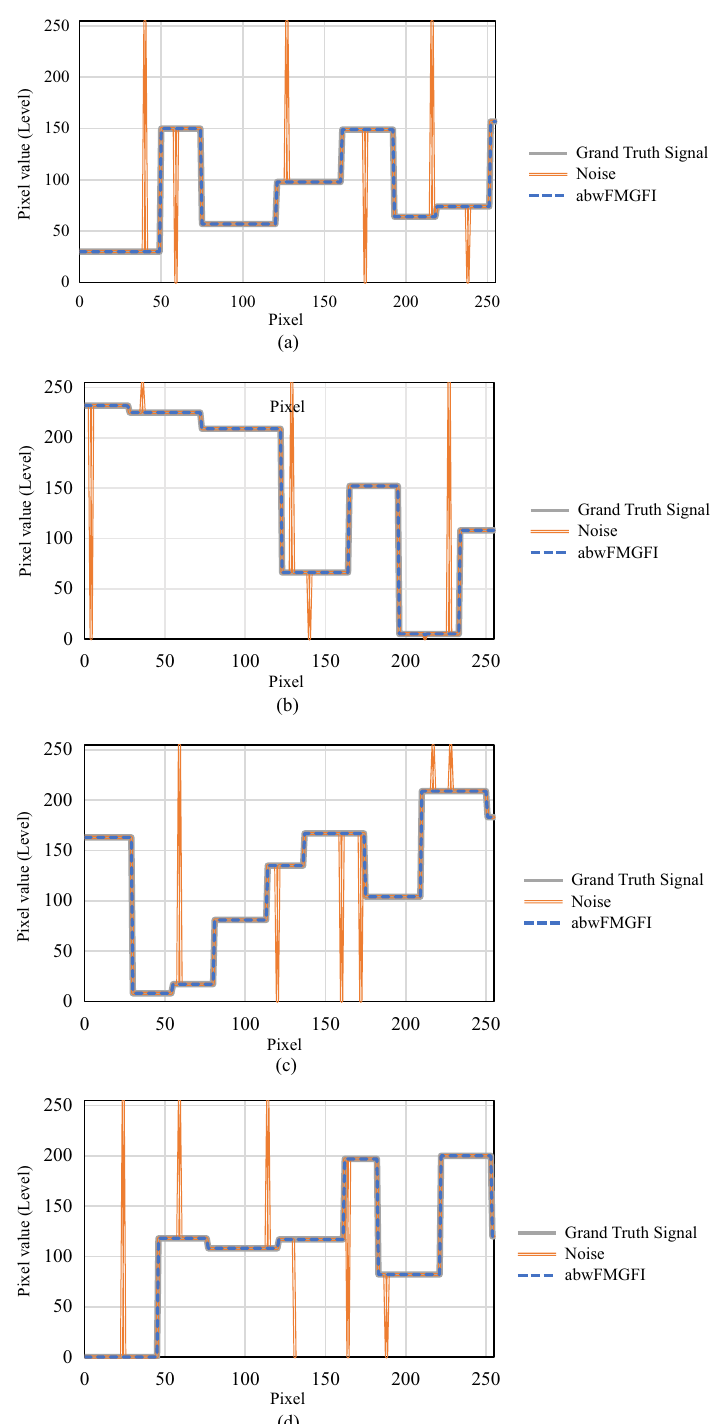
Figure 5. Filtering result for the vp-GTSs using abwFMGFI. ( a ) Pattern 1; ( b ) Pattern 2; ( c ) Pattern 3; ( d ) Pattern